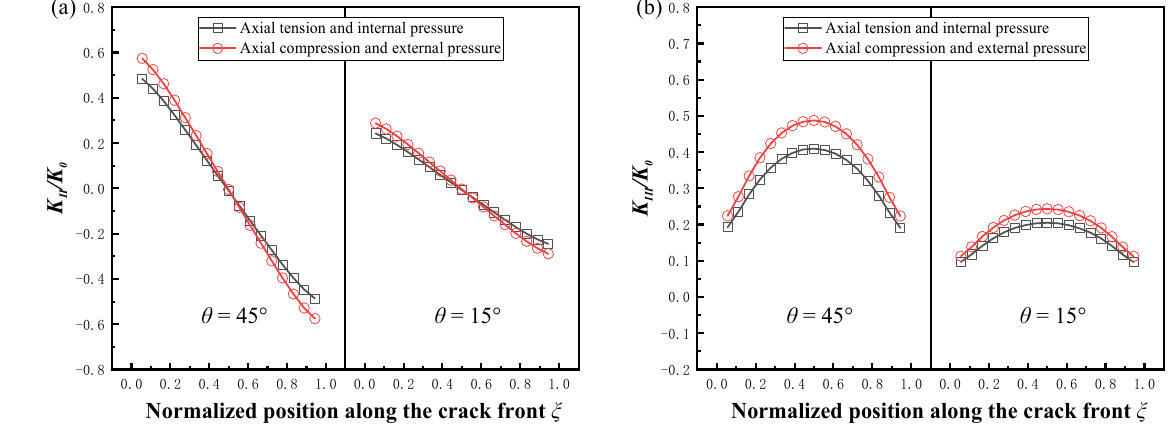
Figure 6. Comparison of SIFs under tension and compression loads with different angles, µ = 0, a/t = 0.2, a/c = 0.8. ( a ) Normalized K II , ( b ) normalized K III .